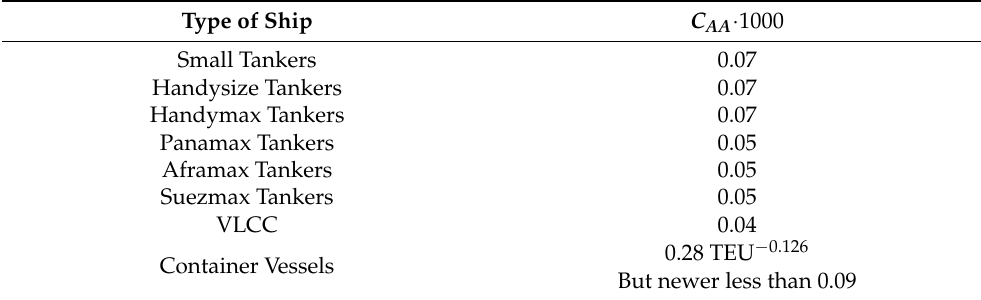
Table 5. Air resistance coefficient C AA .